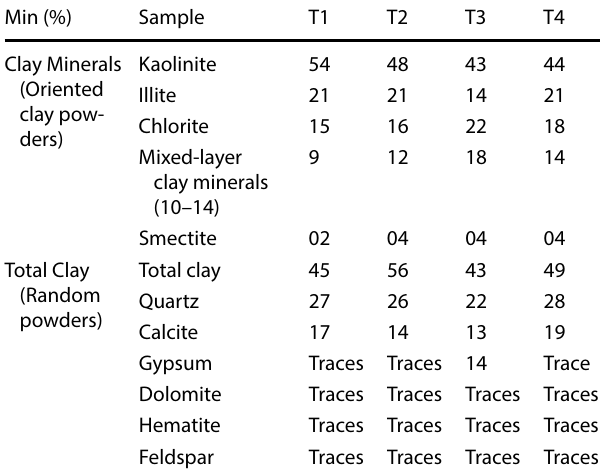
Table 1 Mineralogical composition of the four different samples T1 to T4 (bulk mineralogy and the clay fraction)